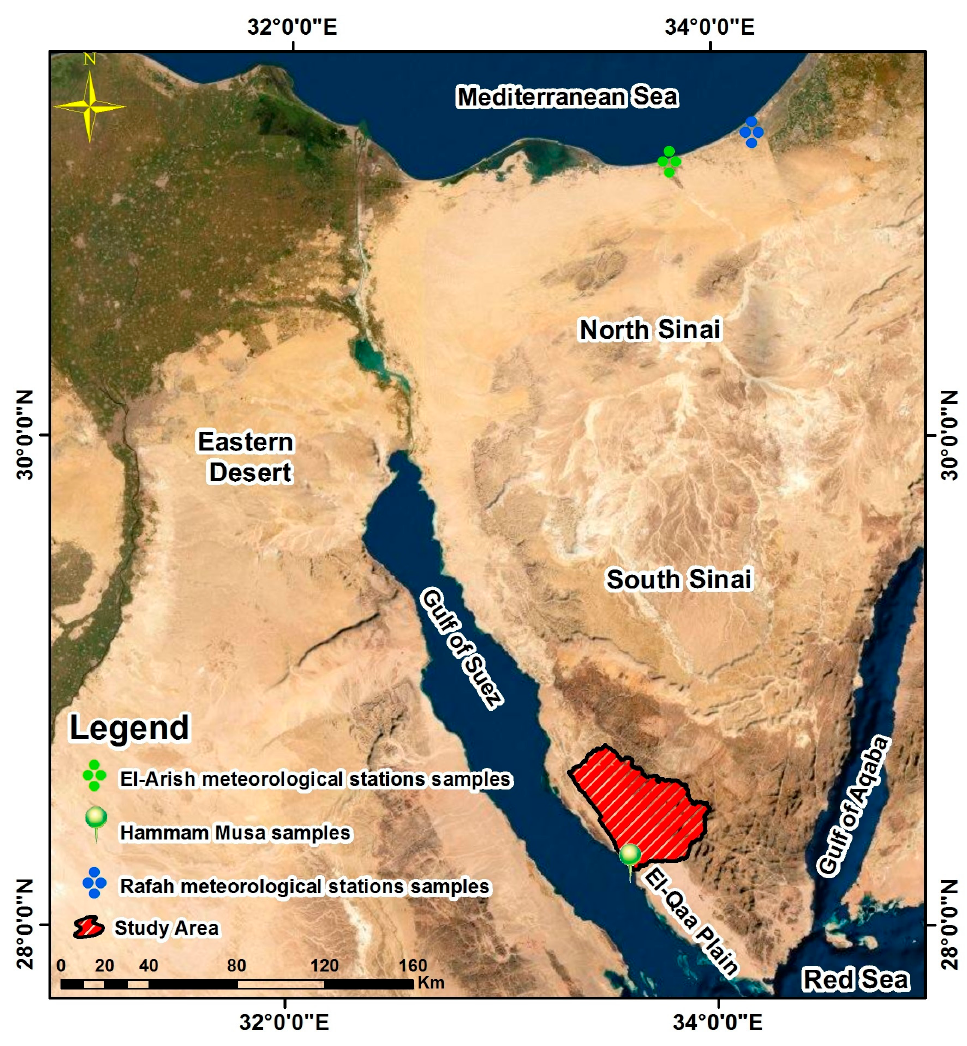
Figure 1. The location of the study area.